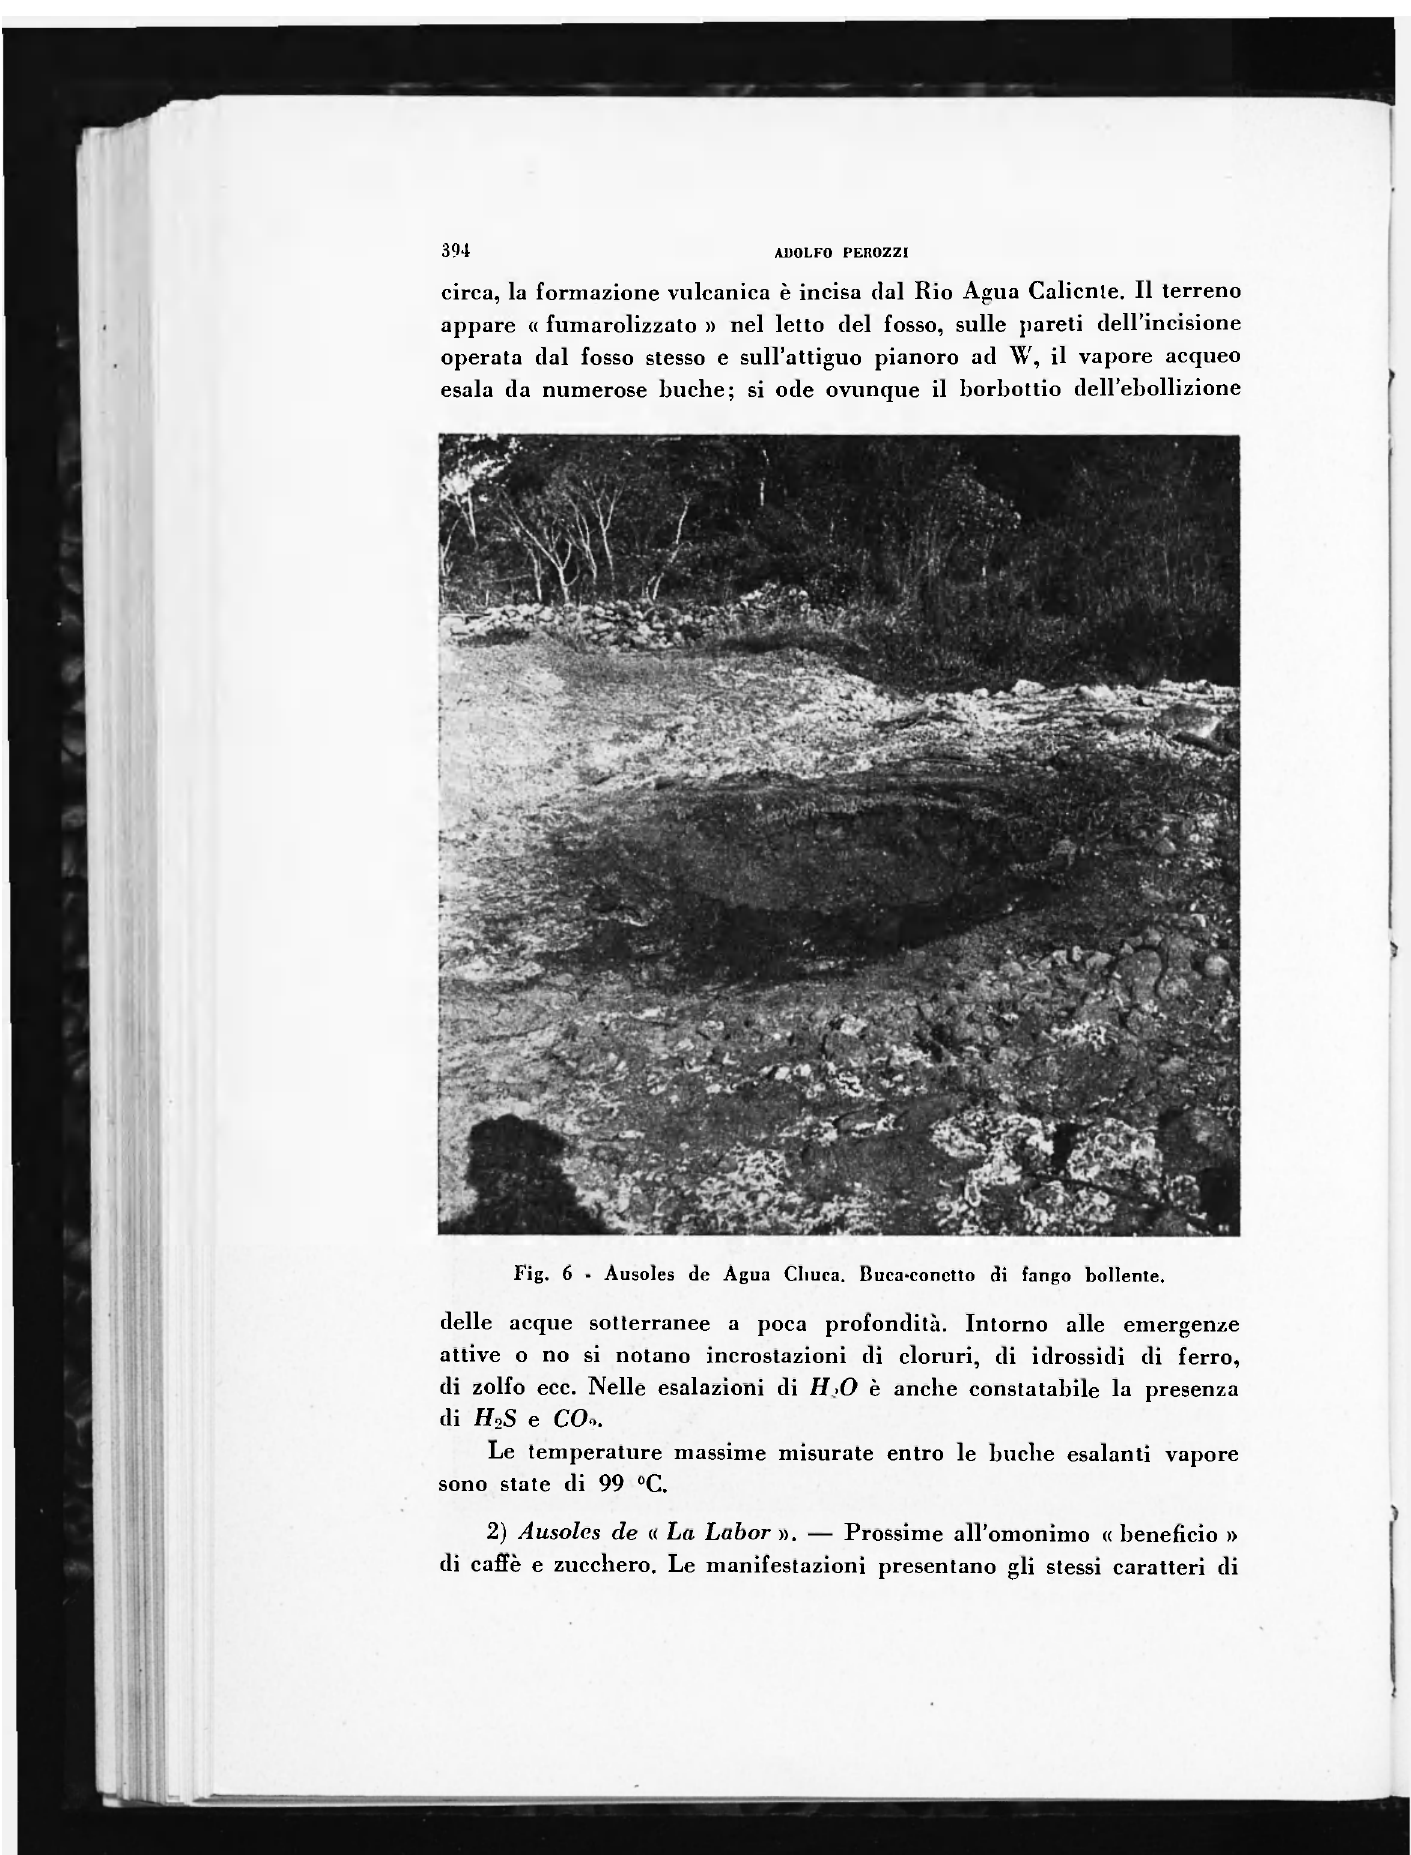
Fig. 6 - Ausoles de Agua Cliuca. Buca-conetto di fango